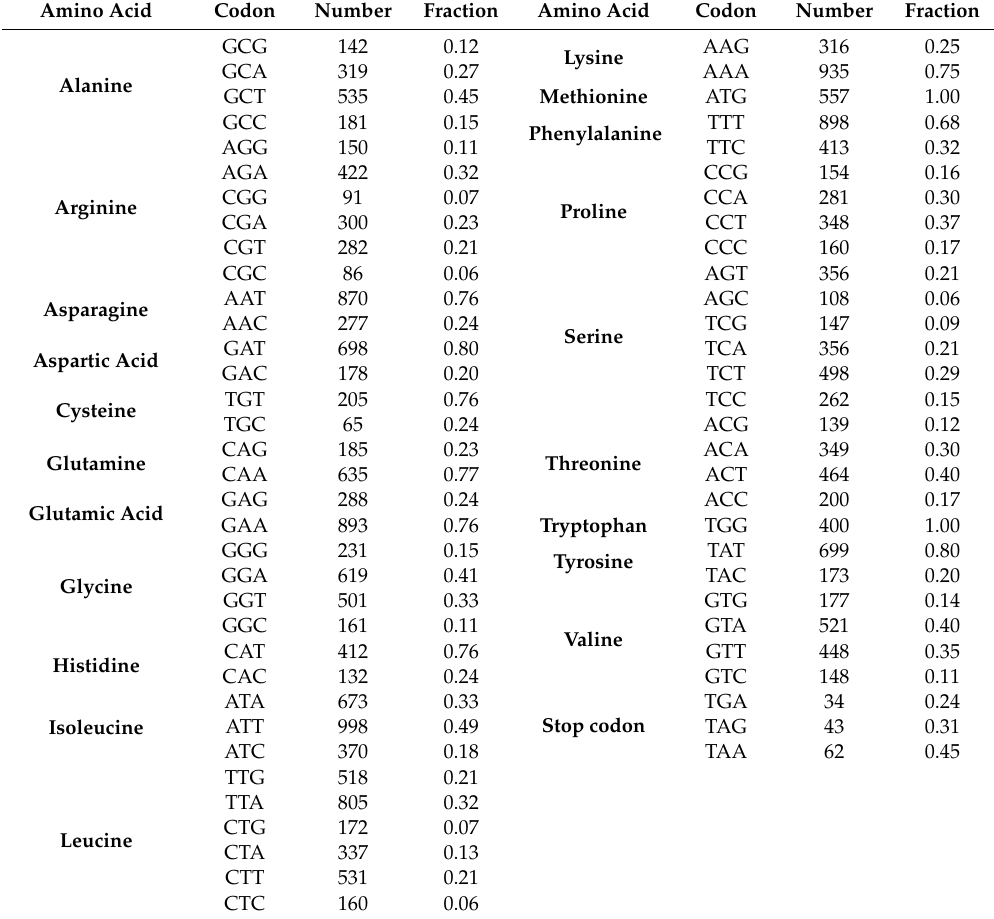
Table 3. Codon usage in the plastid genome of A. camansi